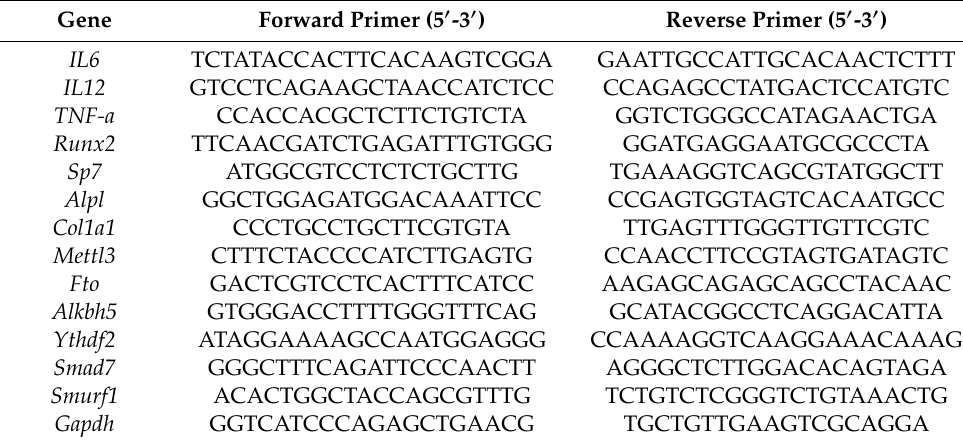
Table 2. Primer sequences for